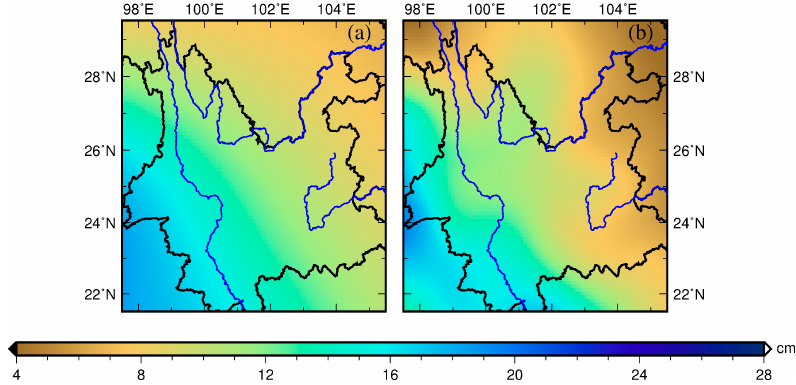
Figure 7. TWS ( a ) inferred from GRACE and ( b ) modeled from GLDAS.